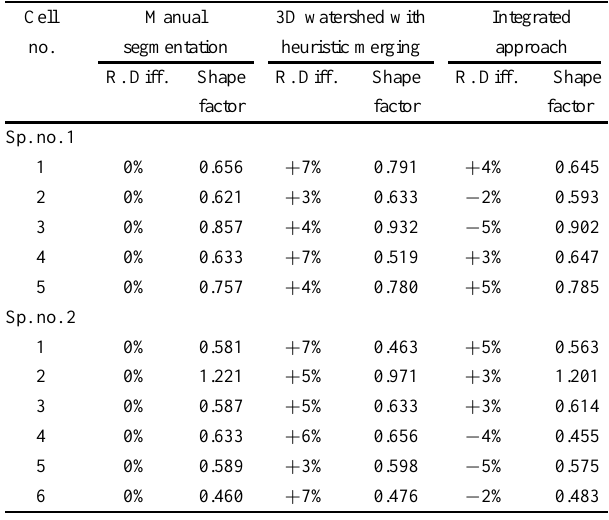
Comparative study of different region based segmentation method corre- sponding to their ability in measuring simple features Manual